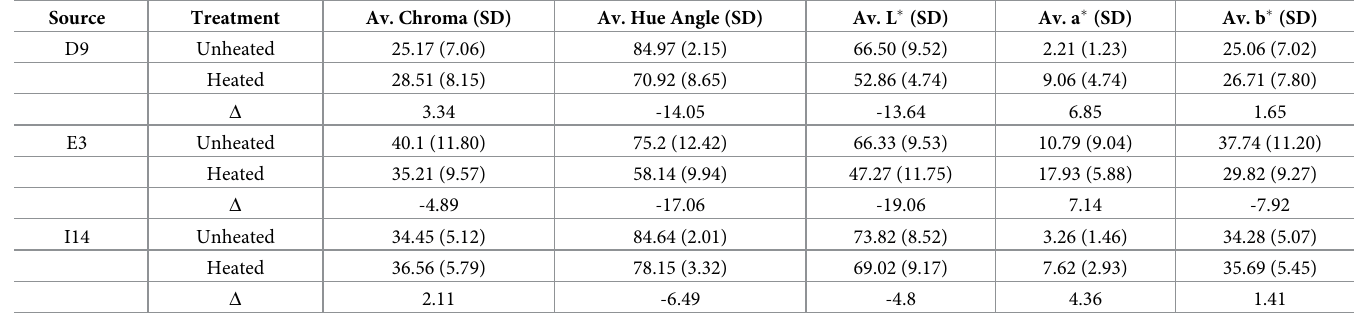
Table 2. Colorimetry results by silcrete source and heat treatment state with average CIE L � a � b � and standard deviation from unheated to heated. Source Treatment